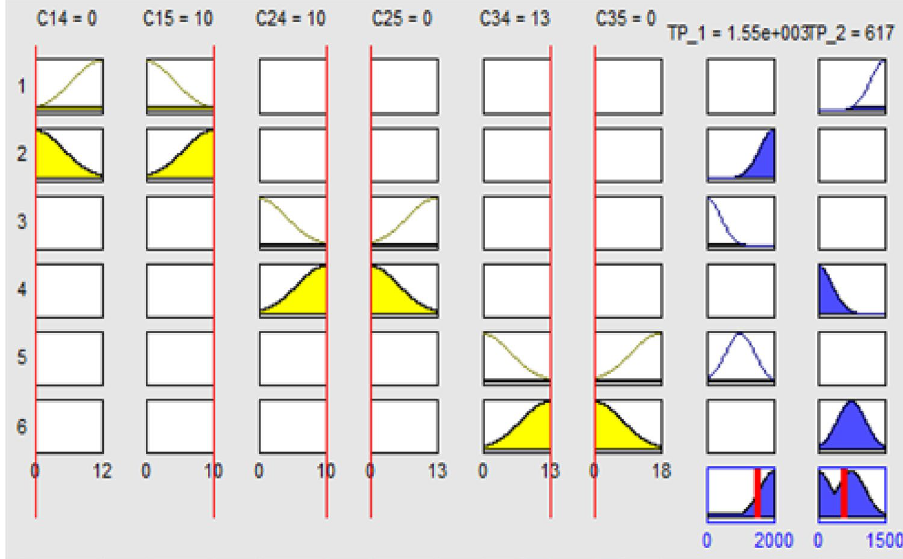
Fig. 4 Rule viewer for input and output